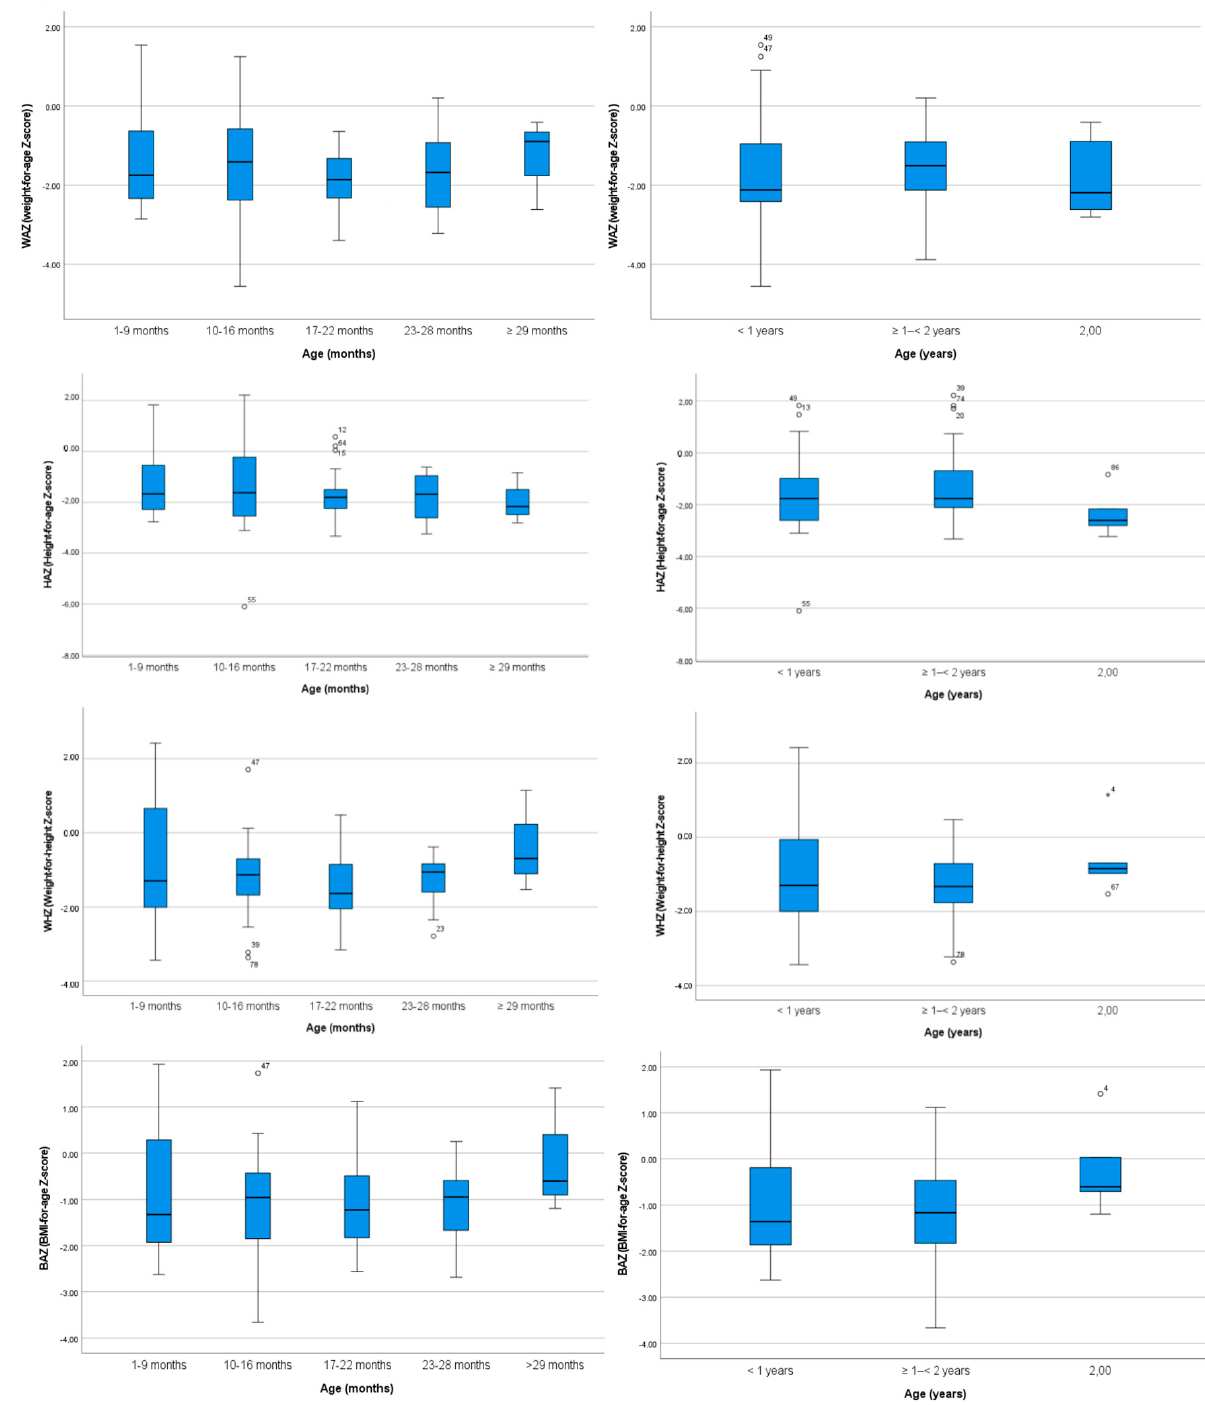
Figure 2. Median, maximum, and minimum values of normalized data of the WAZ, HAZ, WHZ, and BAZ for the groups of age. The circle and * are values out of range “outlier” in the distribution. Table 4 reflects no significant differences in these previous values, including